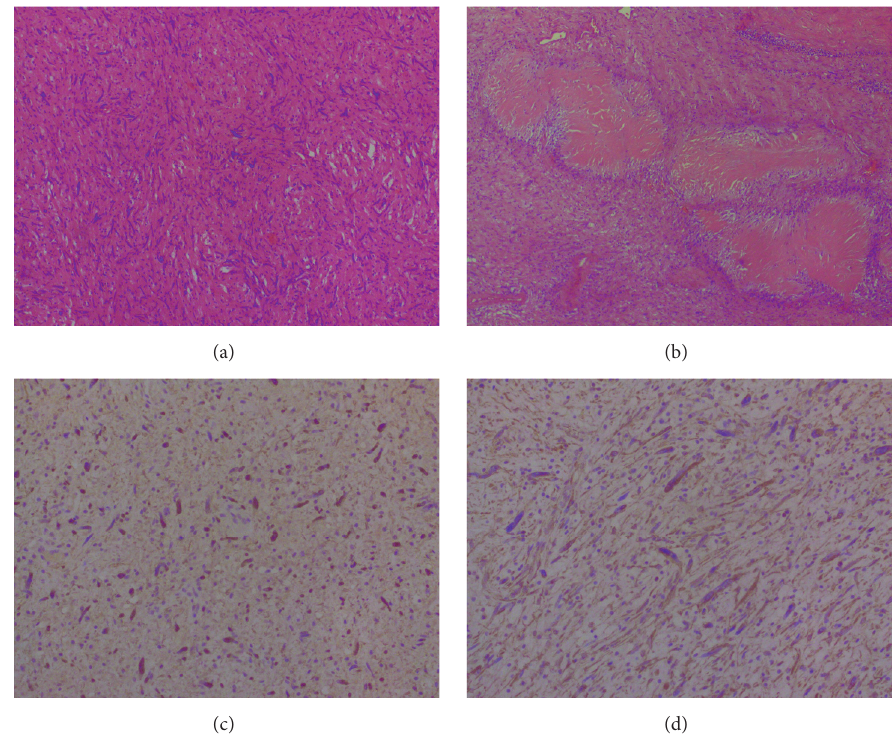
Figure 4: Histological images: (a) intense nuclear atypia (hematoxylin and eosin stain, × 100), (b) Verocay bodies (hematoxylin and eosin stain, × 100), (c) immunohistochemical reaction for S-100, and (d) immunohistochemical reaction for